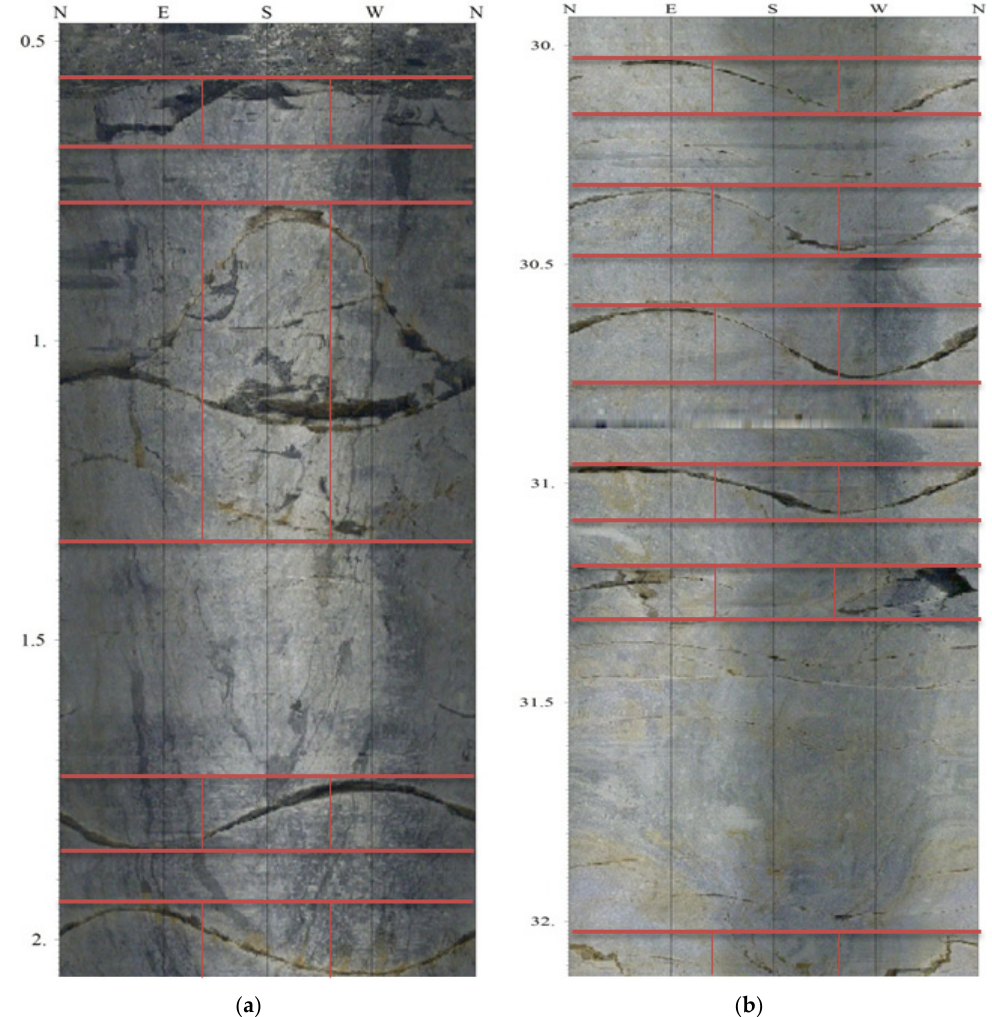
Figure 5. Results of the classification of structural planes. ( a ) Area division of the structural planes shown in Figure 3a; ( b ) Area division of the structural planes shown in Figure 3b.